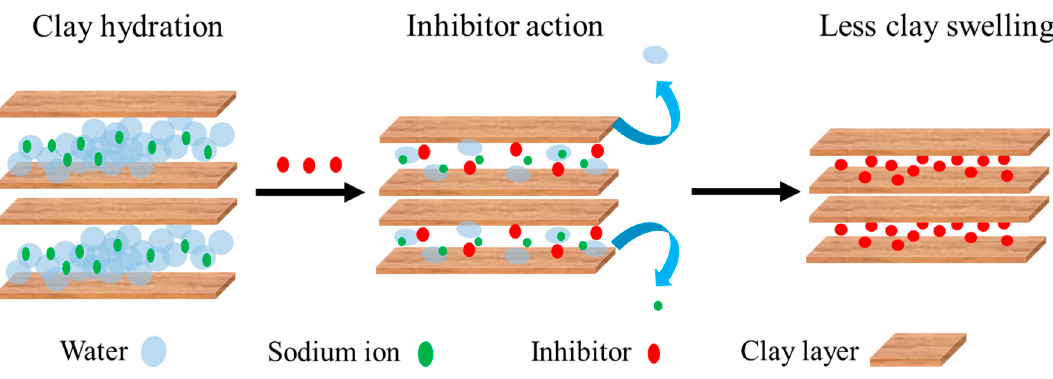
Figure 7. Inhibition mechanism of TEYA.